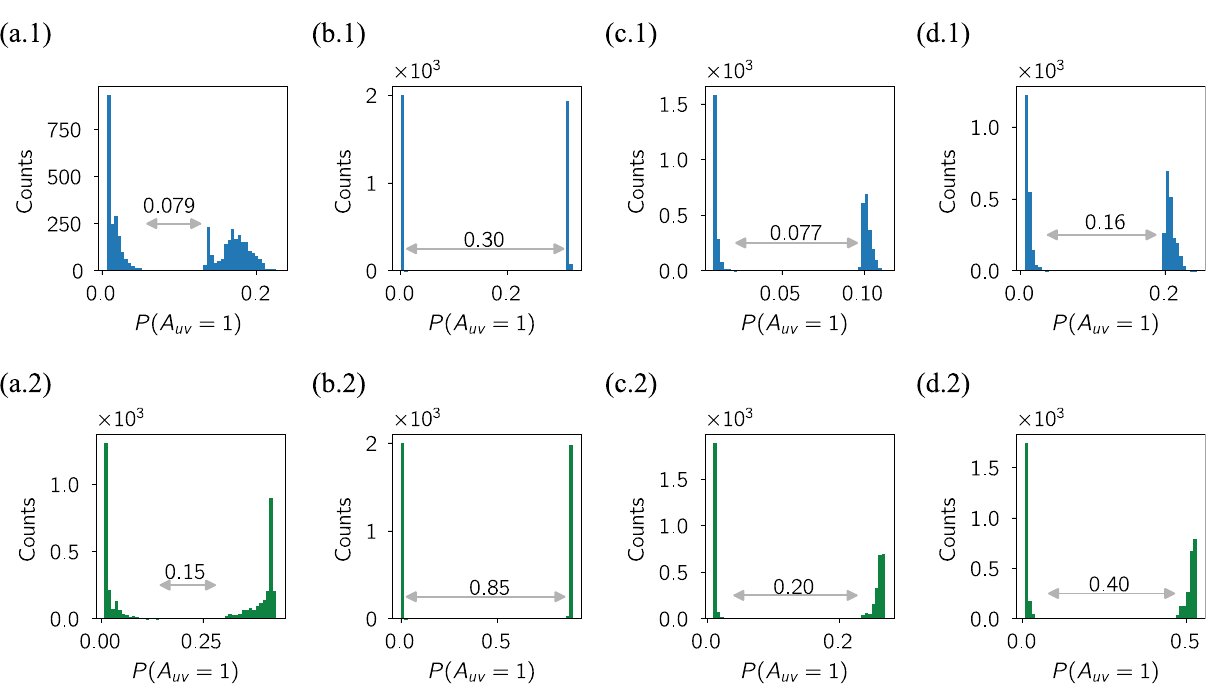
Figure 5. The histogram of node similarity scores in our triplet transition (TT) method for ( a ) Turkish Shareholder networks, ( b ) Wikipedia Mathematician networks, ( c ) College Message networks, and ( d ) Email networks. The precise values are not important as the important feature is the clear separation of the node similarity scores into two groups. One cluster c 0 appears to have a ‘low’ probability that a link will exist in the next snapshot and the other cluster has ‘high’ probability. We therefore predict that if the node pair has a score in the lower score cluster c 0 , then a link will not exist in the next snapshot. Conversely, if a node pair exists in the higher score cluster c 1 , then we predict a link will exist between this node pair in the next snapshot. The first row, where the histogram is plotted in blue is the clustering results for the M 4 while the second row, where the histogram is plotted in green is the clustering results for the M 8 . It shows that the M 8 has higher separation between two clusters than M 4 . The results for each network are based on samples which contain at least 2000 node-pairs with an initial link and at least 2000 more node pairs which started without a